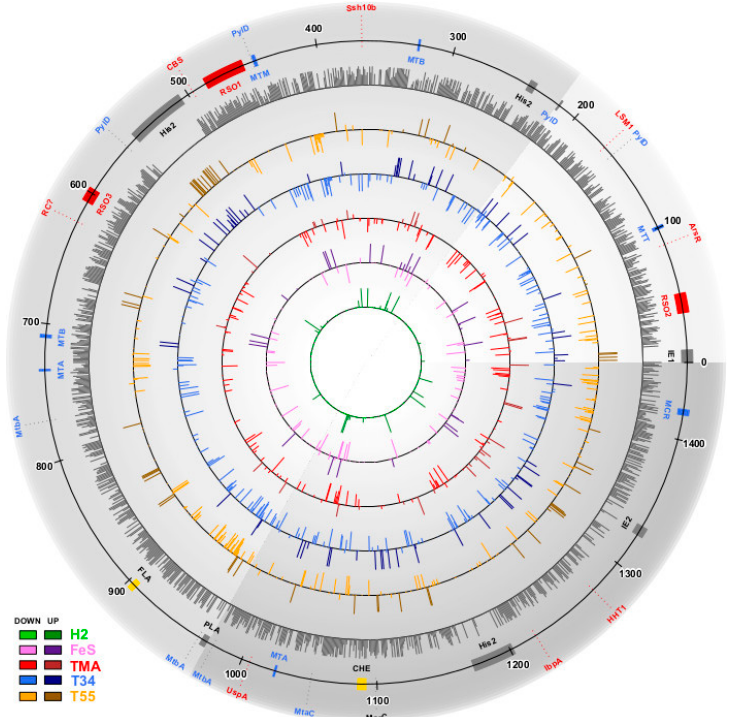
Figure 1. Schematic map of protein expression in different conditions along the Methanonatronarchaeum thermophilum AMET1 genomic contigs. The grey transparent sectors show M. thermophilum AMET1 genomic contigs as follows: AMET1_2–light grey, AMET1_3–medium grey, AMET1_4–dark dray (minor contigs are not shown). Dark grey circle shows base (optimal) conditions relative protein abundance level. The inner cycles represent up- and down regulated genes in different experimental conditions according to the colour code shown on the left bottom corner of the Figure. Genes and genes clusters described in the paper shown by shapes and lines as follows: Red—the most abundant genes; Red—RSO1,2,3—three ribosomal; Blue—methanogenesis related genes; Blue—methanogenesis operons: MTT-trimethylamine-corrinoid methyltransferase, MTB-dimethylamine-corrinoid methyltransferase superoperons; MTM-methylamine-corrinoid methyltransferase, MTA-methanol-corrinoid methyltransferase; MCR-methyl coenzyme M reductase; Yellow—chemotaxis operon (CHE) and archaellum (FLA). Black—mobile elements: His2—His2 virus related loci, PLA-putative plasmid, IE1 and IE2—integrated elements.